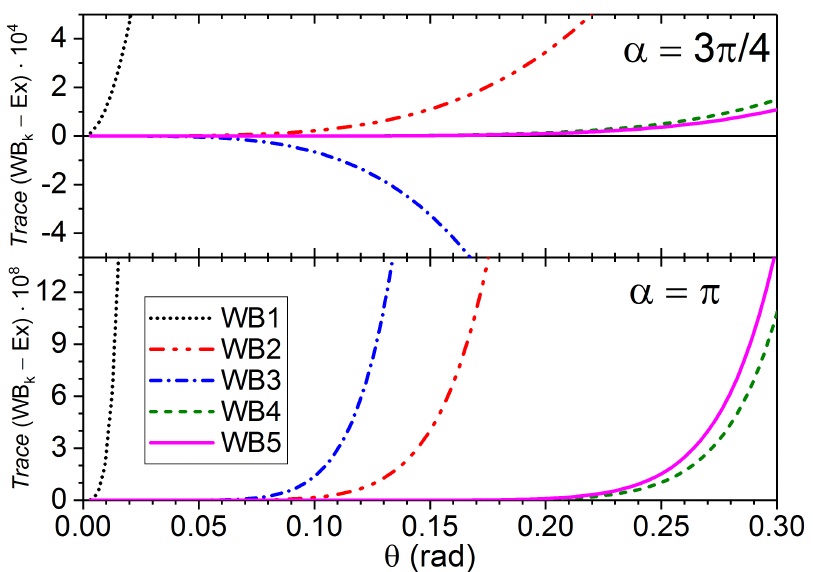
Figure 5. Error in the approximations to the matrix trace as a function of the rotation angle θ , for two values α = 3 π /4 and π